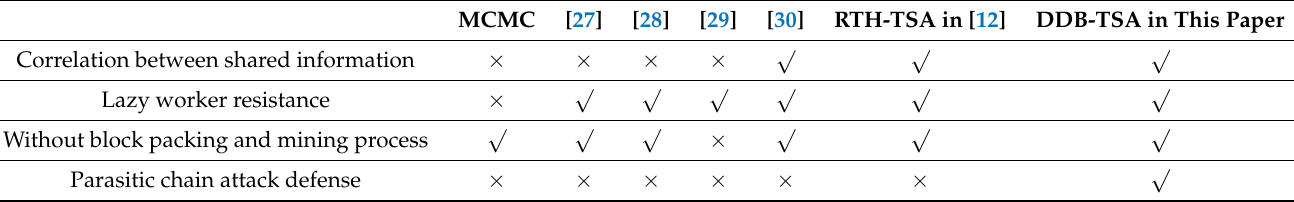
Table 3. Tip Selection